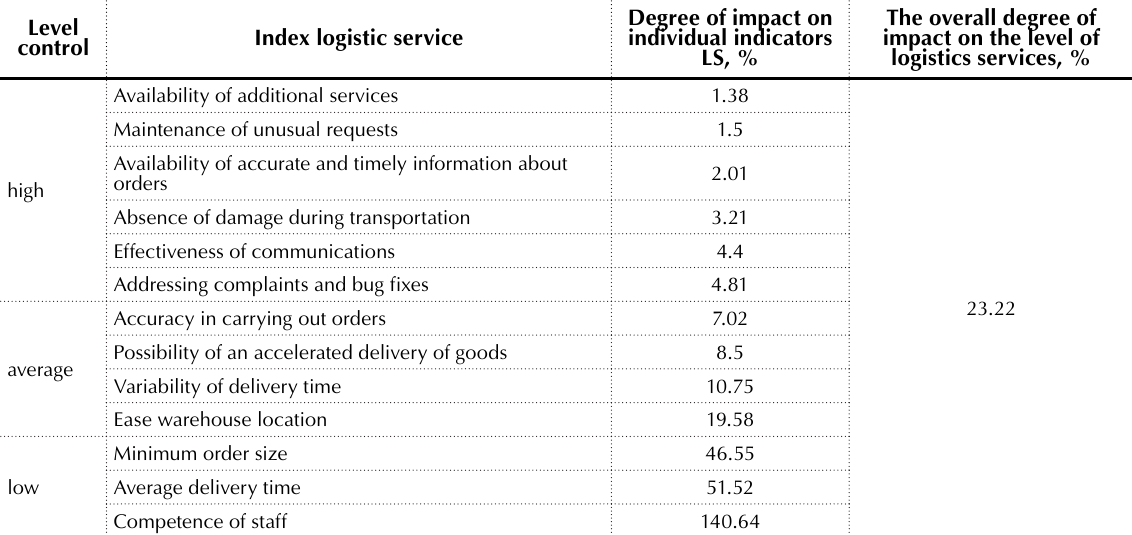
Table 3. Degree of impact of the enterprise on logistics service Level